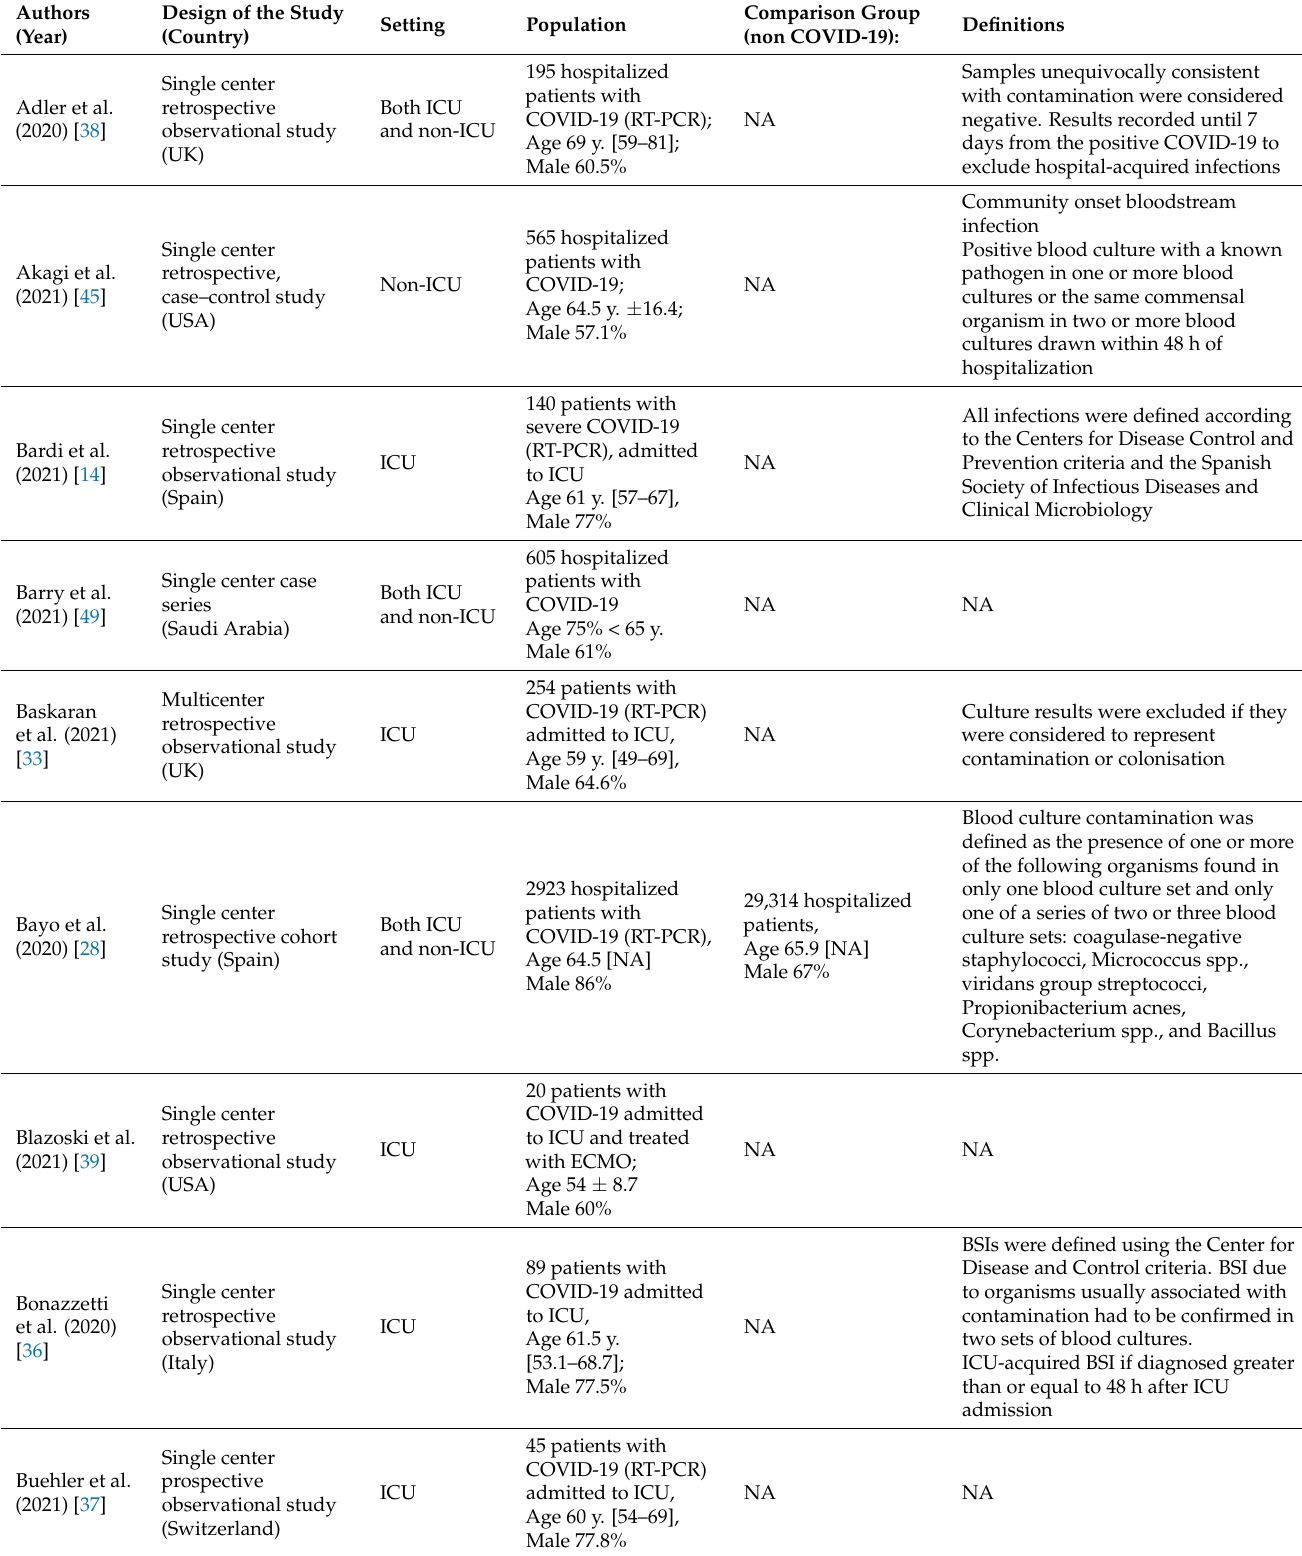
Table 1. Characteristics of the included studies. The table shows the main characteristics of the included studies, as reported by the authors. BSI, bloodstream infection; CRBI, catheter-related bloodstream infection; ECMO, extracorporeal membrane oxygenation; ICU, intensive care unit; NA, not available; RT-PCR, real-time polymerase chain